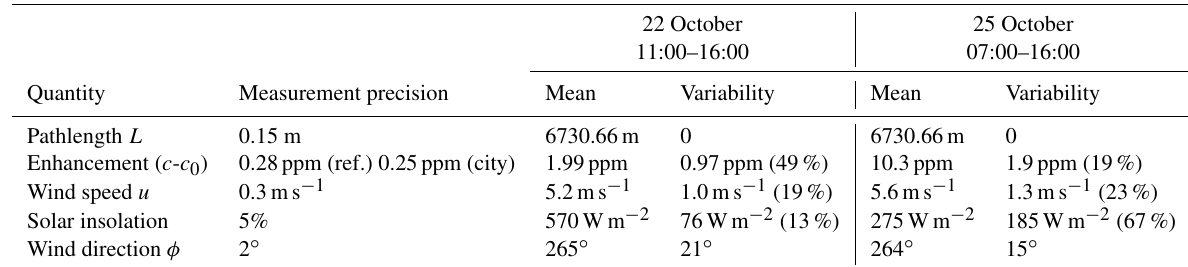
Table 1. Parameters used to calculate the emission rate from Eq. (4). The measurement precision refers to the instrument uncertainty in the measurement quantity. The variability refers to the observed environmental variability over the measurement period. The variability from the enhancement, the wind direction, and the wind speed drive the observed variability in the estimated Q(t) . The distance from a given source location to the DCS measurement path, (cid:49)x j , varies with location and has a 5m